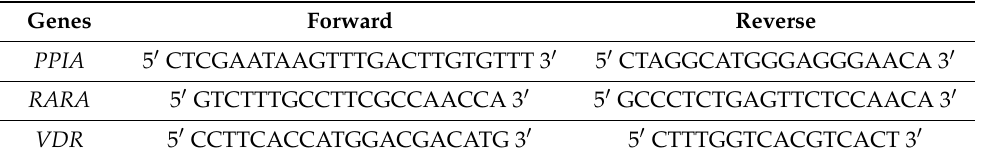
Table 1. Sequences of primers used in this